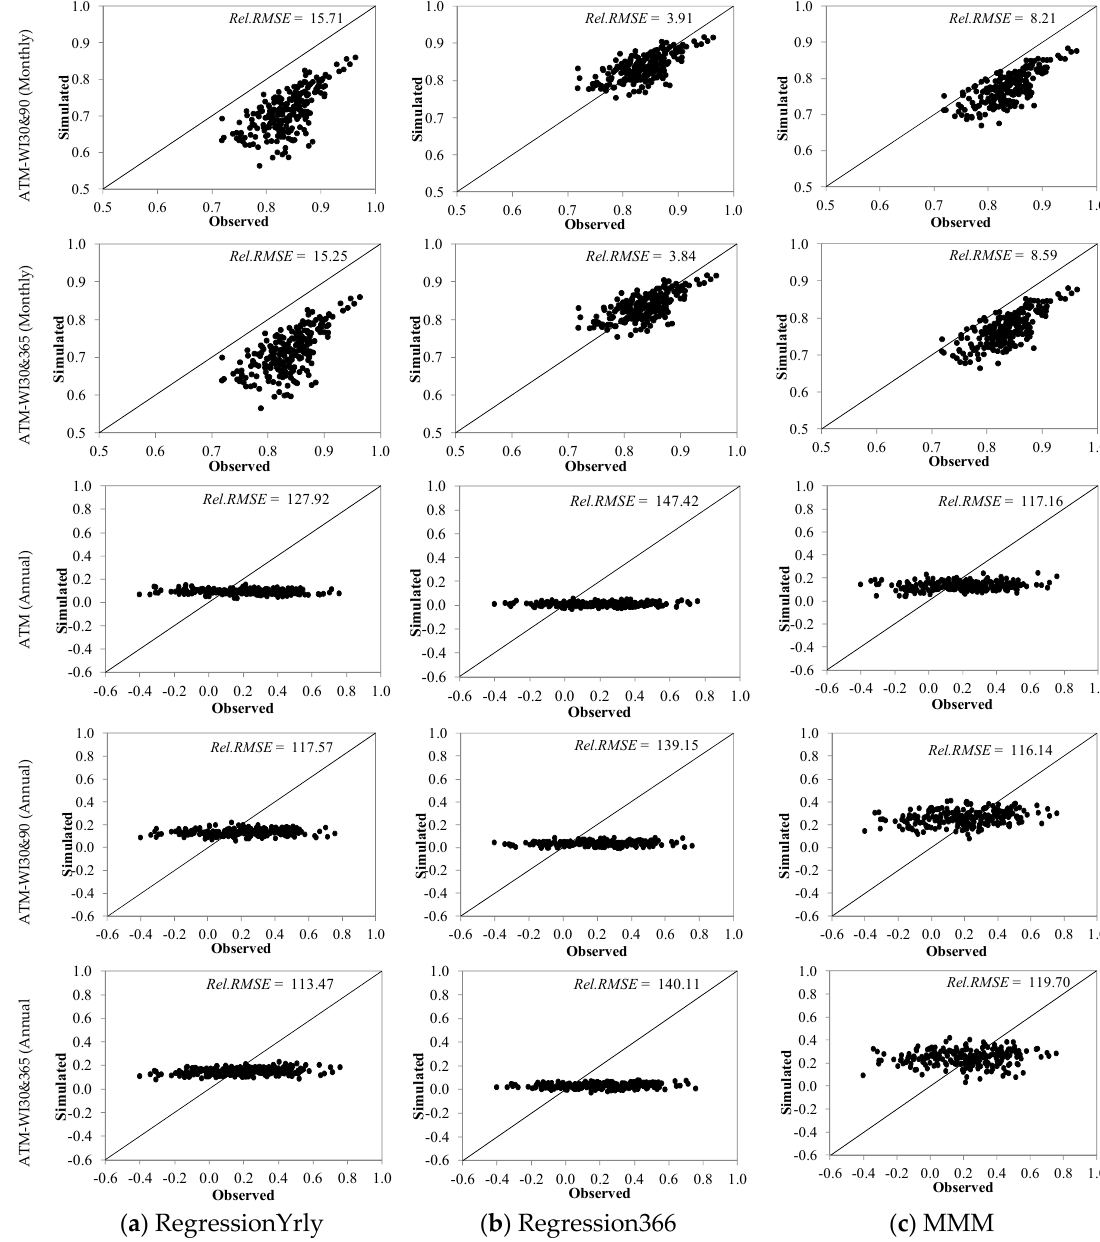
Figure 9. Scatter plots of observed and models simulated daily, monthly and annual cross correlations using single site model (Validation period). Rel. RMSE values are shown on the top right of each plot: ( a ) using RegressionYrly model; ( b ) using Regression366 model; and ( c ) using MMM.